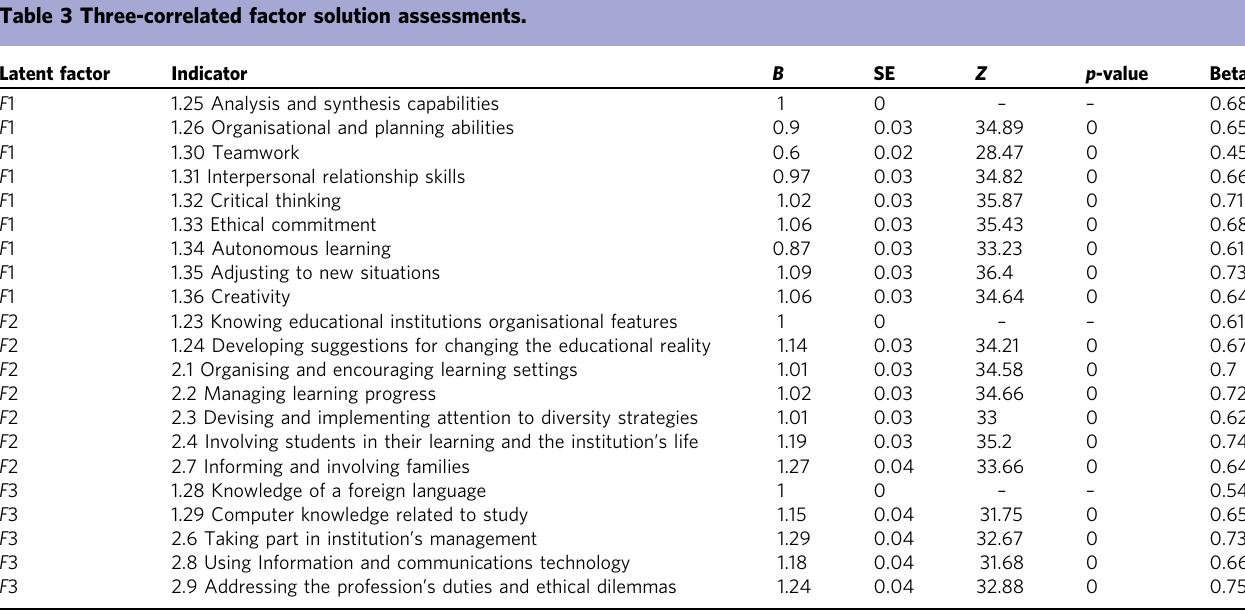
Table 3 Three-correlated factor solution assessments.